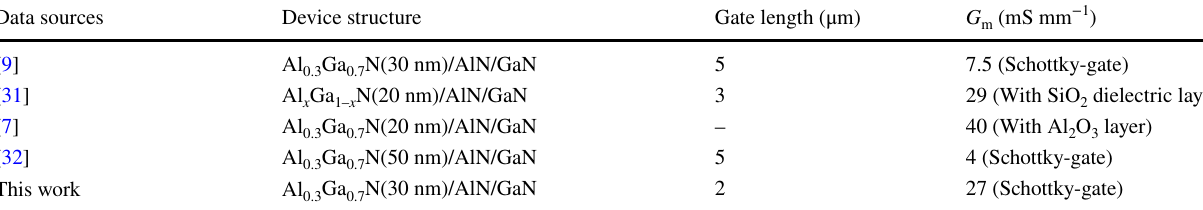
Table 2 Comparison of transconductance in GaN HEMTs Data